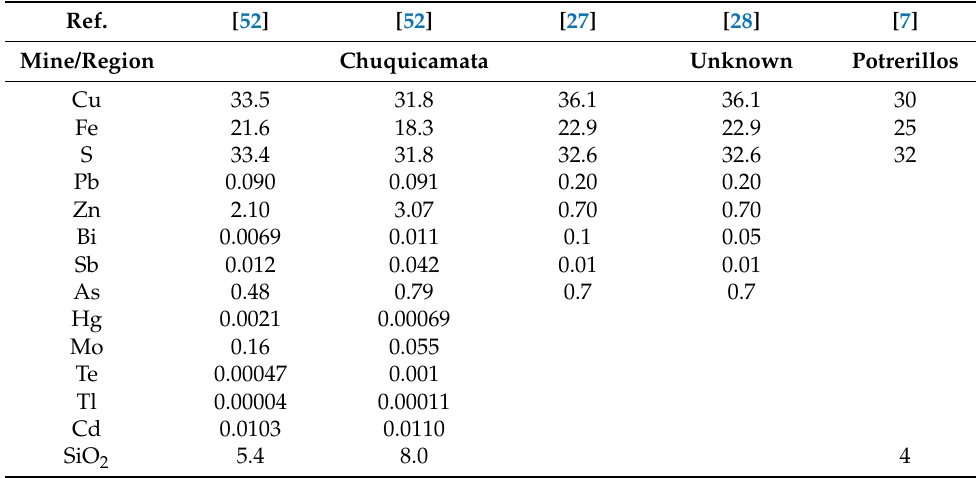
Table 5. Chemical composition (wt%) of Chilean copper concentrates.